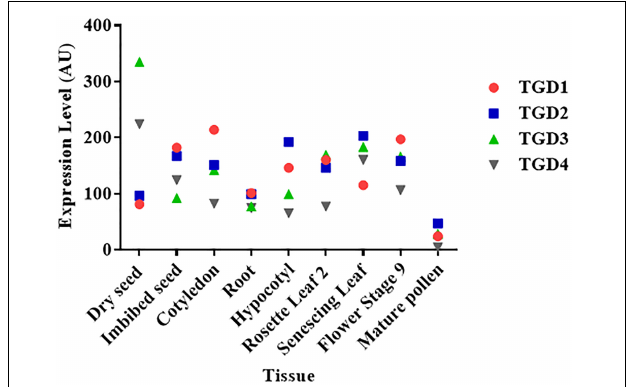
FIGURE 3 | Level of expression of the TGD complex subunits in different Arabidopsis thaliana plant tissues. The expression levels of each gene in arbitrary units (AU) were retrieved from the Arabidopsis eFP browser (Winter et al., 2007). Data for the TGD5 subunit were not